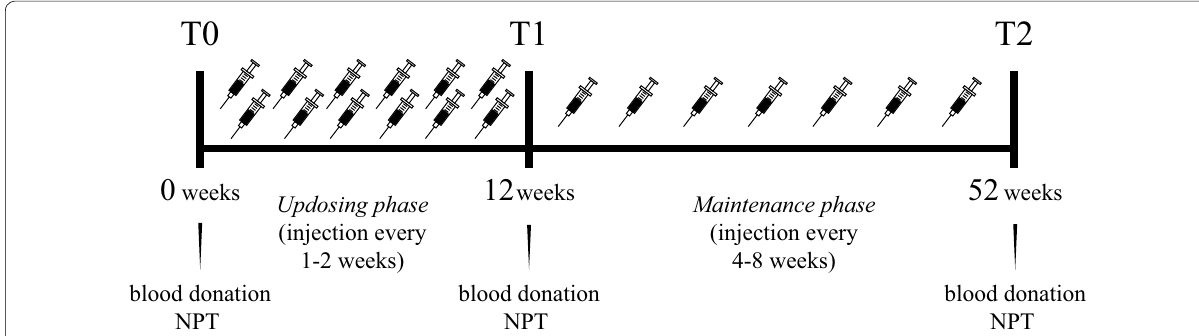
Fig. 1 AIT timeline and study design. Subcutaneous immunotherapy with birch pollen extract was performed with 11–13 injections at intervals of 1–2 weeks during the updosing phase. After reaching the maintenance dose, injections were further administered every 4–8 weeks until 52 weeks. Serum samples were obtained before treatment (T0), 2 weeks after reaching maintenance dose (T1), and 1 year after starting treatment (T2). At the same time points, NPT were performed and RTSS were